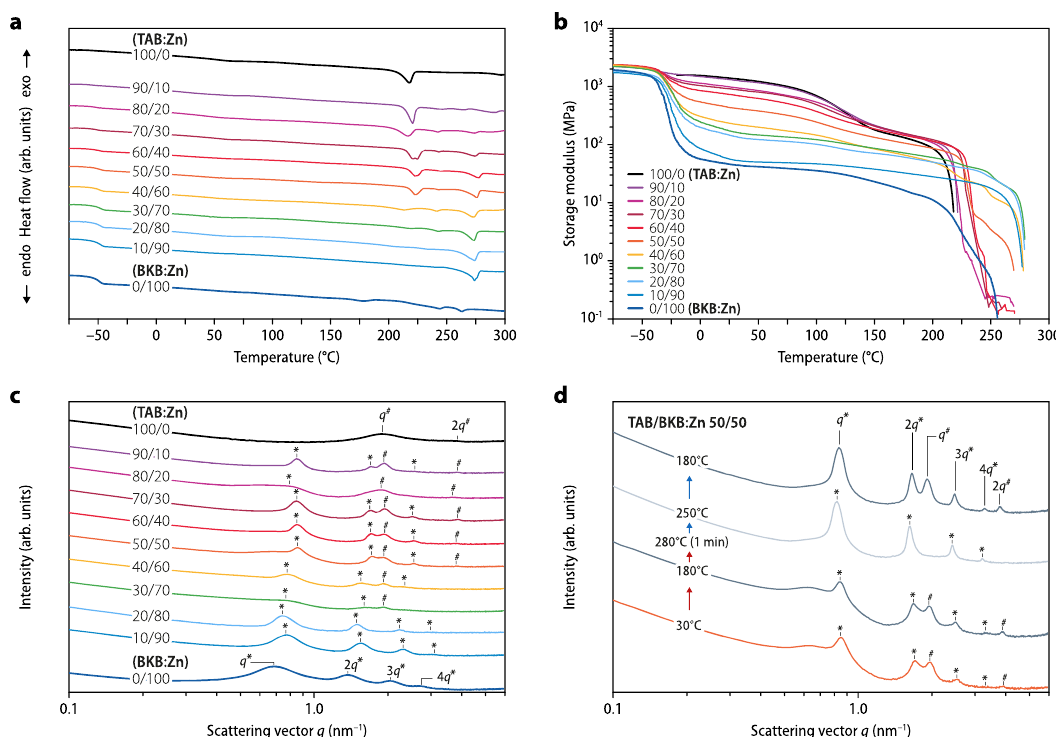
Fig. 2 Thermal, thermomechanical, and structural properties of the MSPs and their copolymers. a Differential scanning calorimetry (DSC) traces ( fi rst heating), b dynamic mechanical analysis (DMA) traces, and c small-angle X-ray scattering (SAXS) pro fi les of the neat metallosupramolecular polymers TAB:Zn and BKB:Zn, as well as of the TAB/BKB:Zn copolymers with the indicated TAB/BKB weight ratio (wt/wt%). d Temperature-dependent SAXS pro fi les of TAB/BKB:Zn containing TAB and BKB in a 50/50 wt/wt% ratio recorded at 30 and 180 °C, after cooling from the melt (1 min at 280 °C) to 250 °C, and after cooling to 180 °C. Heating and cooling rates were 10 °C min – 1 . The DSC traces and scattering pro fi les are vertically shifted for